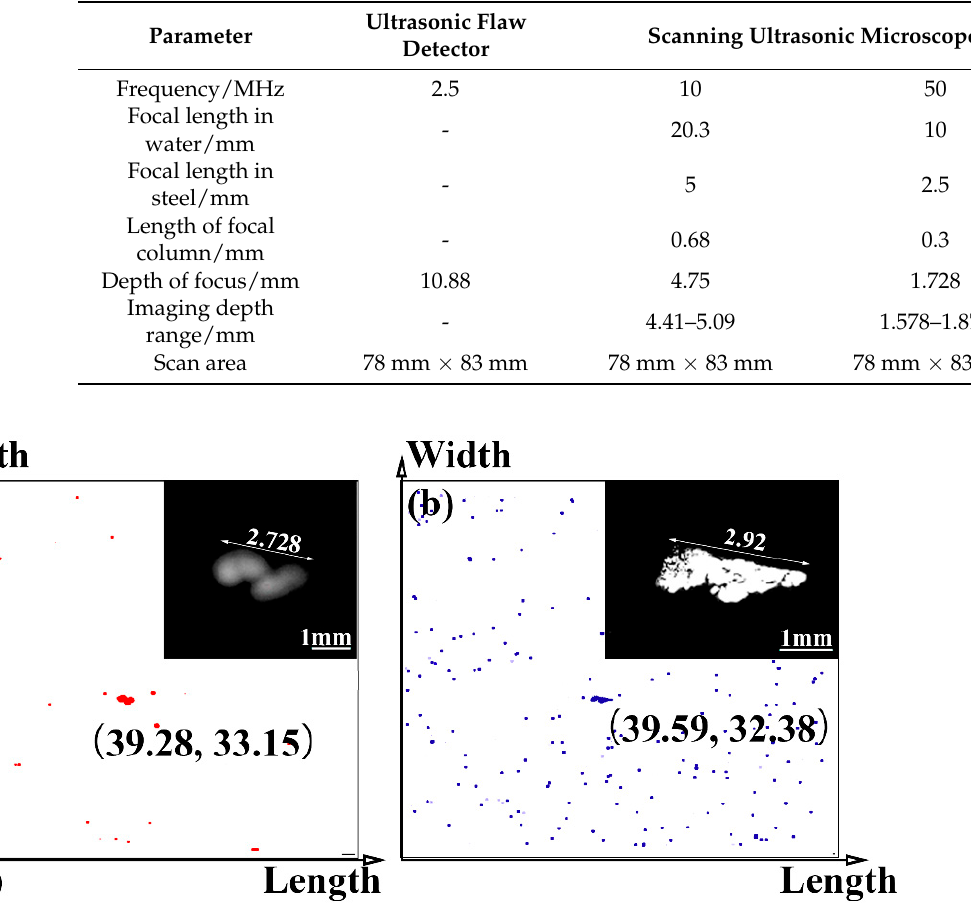
Table 2. Technical parameters of different ultrasonic probes.